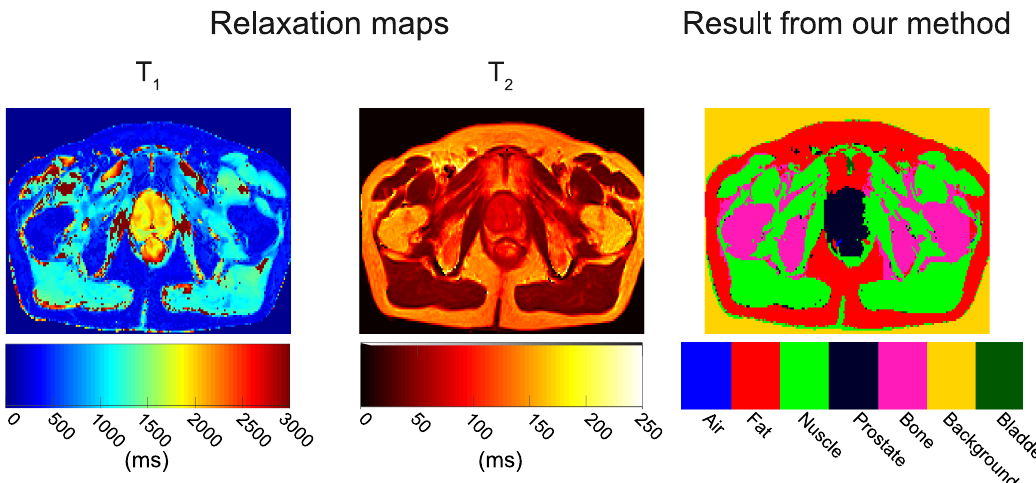
Fig 7. Relaxation maps and classification results of volunteer 3. Even though this volunteer is affected by noncancerous prostatic hyperplasia, the T 1 map presents a rather homogeneous range of values in the prostate area (1600–2000 ms). The T 1 map also presents a considerable amount of misleading values ( � 2000 ms) in the muscle areas. On the T 2 map, the muscle areas are well defined ( < 70ms) and clearly differentiable from the rest of the tissues (prostate, fat, and bone marrow) which seem to merge in a single region. In any case, the SVM accuracy is excellent: prostate = 89.1%, muscle = 98.8%, fat = 100%, and bone marrow = 89.7%. Bladder and air are not present. All features were used to perform the